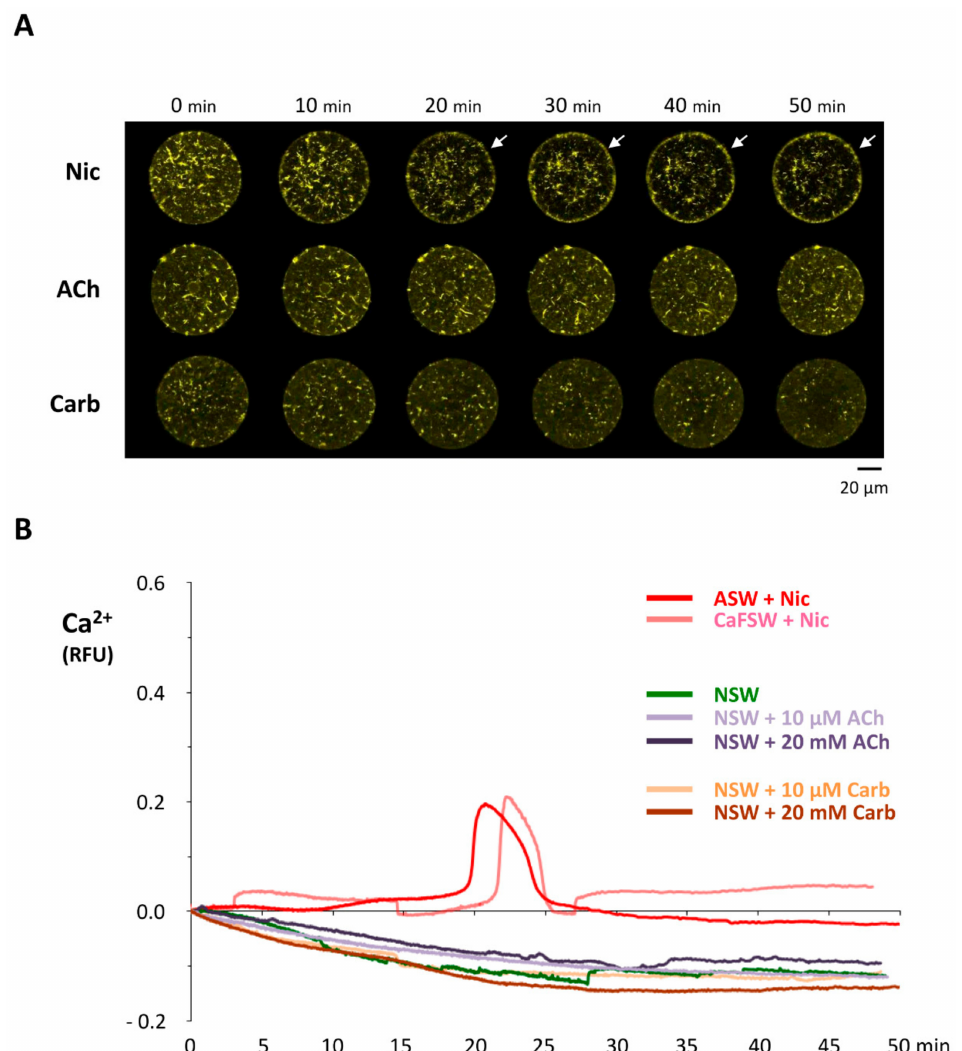
Figure 9. Unique e ff ects of nicotine on subplasmalemmal actin filaments and the intracellular Ca 2 +